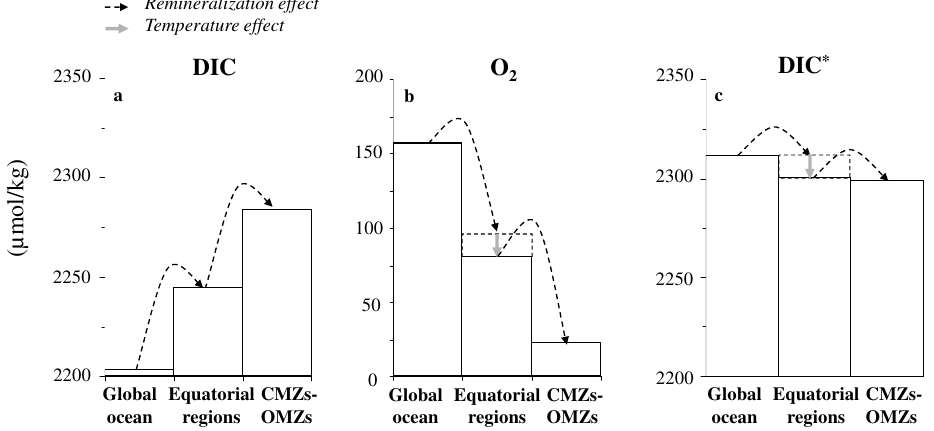
Fig. 4. DIC (a) , O 2 (b) and DIC ∗ (c) mean concentrations for global ocean, equatorial regions (Indian and Pacific only, where the main intense OMZs are located; between 10 ◦ N and 10 ◦ S; between 175 and 950m, in the same depth layer than the subsurface OMZ core), and CMZs-OMZs. In dashed arrows, the remineralization effect from the global ocean towards the Equatorial regions and the CMZs-OMZs. In thick grey arrows, the temperature effect mainly decreasing the solubility, not visible on DIC (a) because of the buffer effect, but on O 2 (b) and DIC ∗ (c)